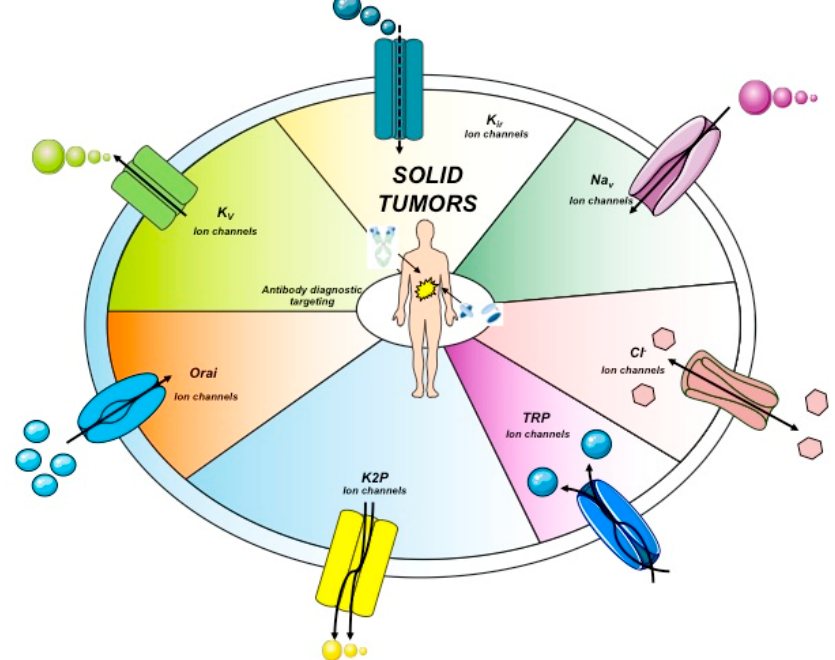
Figure 2. Ion channels topology expressed in solid cancers. The main ion channels and their structures are reported. These represent the main proteins expressed in solid cancers. K ir , inward-rectifier potassium channel. Table 3. Main ion channels expressed in solid cancers, with their role in tumor biology. Ion channels are indicated using the HGNC (HUGO Gene Nomenclature Committee) classification. Cancers are indicated using the acronyms as follows: BC, breast cancer; PDAC, pancreatic cancer; CRC, colorectal cancer; LC, lung cancer; HC, head cancer; PC, prostate cancer; EC, esophageal cancer; GC, gastric